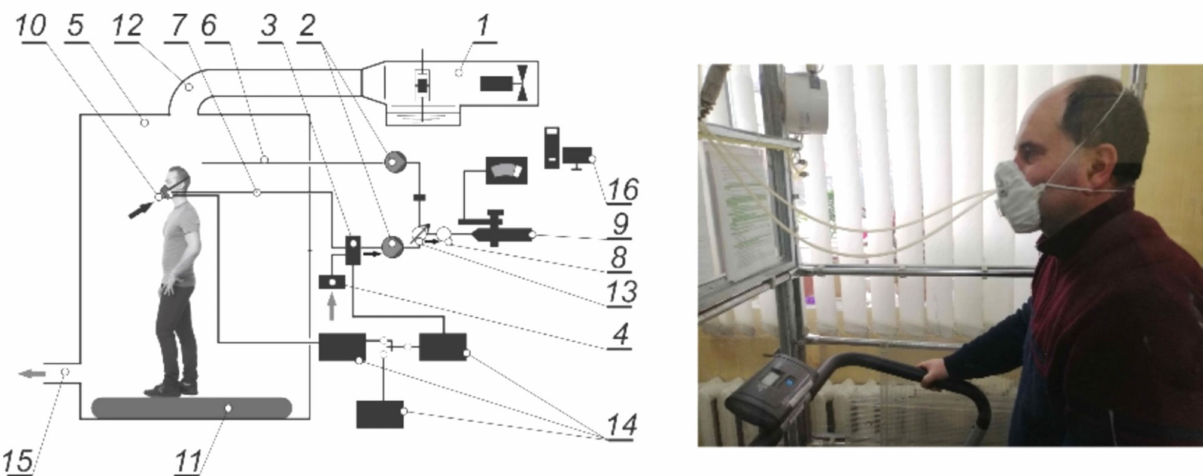
Figure 7. Scheme of a laboratory stand for testing the FDR with test-aerosol with an experimental group participant. Schematic symbols: 1—aerosol generator with a compressor and aerosol line; 2 —aspirator; 3—changeover valve; 4— particulate matter filter; 5—test chamber into which aerosol flows from above; 6—sampling device from the chamber; 7—sampling device from the undermask space; 8—pressure sensor; 9—spectrophotometer; 10—FDR; 11—treadmill located in the test chamber; 12—fresh-air duct and air control valve; 13—clean air inlet; 14—inhalation–exhalation phase distribution system; 15—exhaust ventilation;